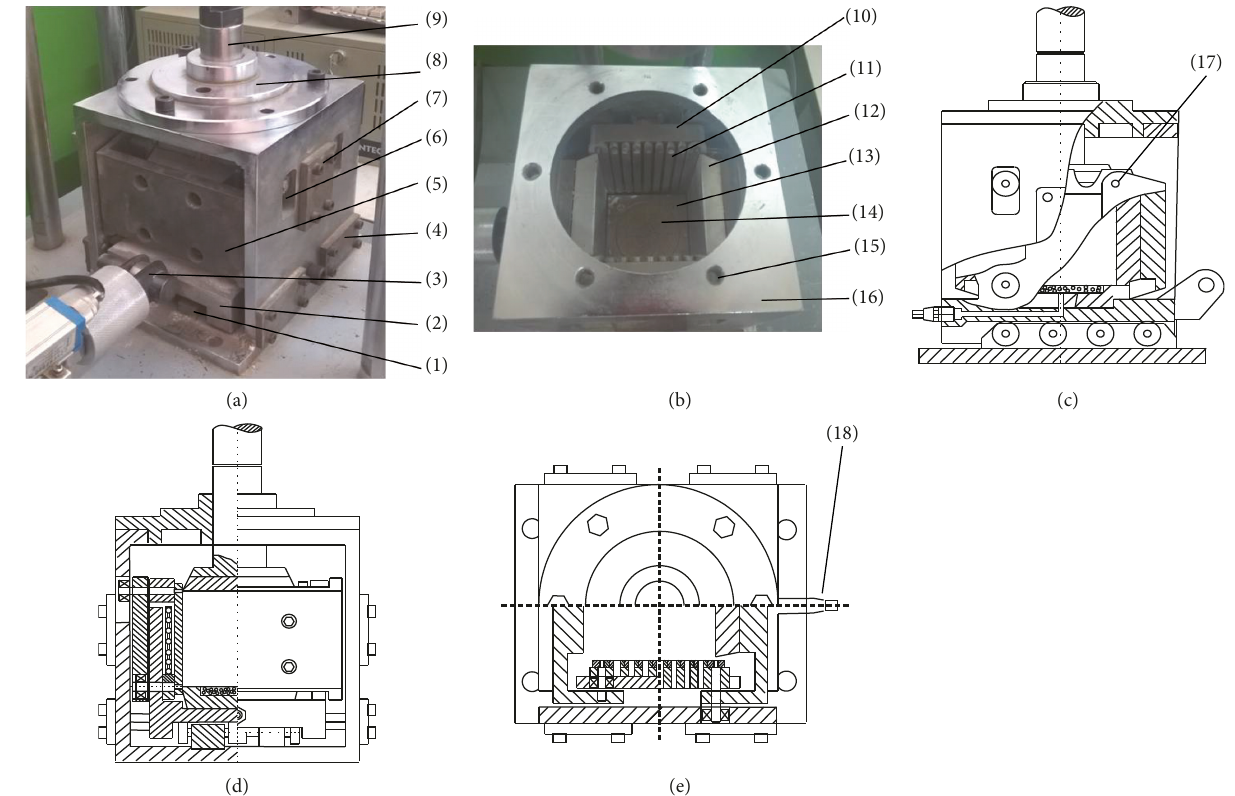
Figure 2: General view (a), top views (b, e), and lateral views (c, d) of pressure cell: horizontal guide (1), bottom platen (2), connecting link (3), support for confining roller (4), arm of confining plate (5), vertical guide (6), support for confining roller of cross beam (7), top cap (8), top platen (9), cross beam (10), rectangular parting stop (11), confining plate (12), base plate for specimen (13), porous stone (14), bolt hole (15), loading frame (16), hinged hole (17), and drainage hole